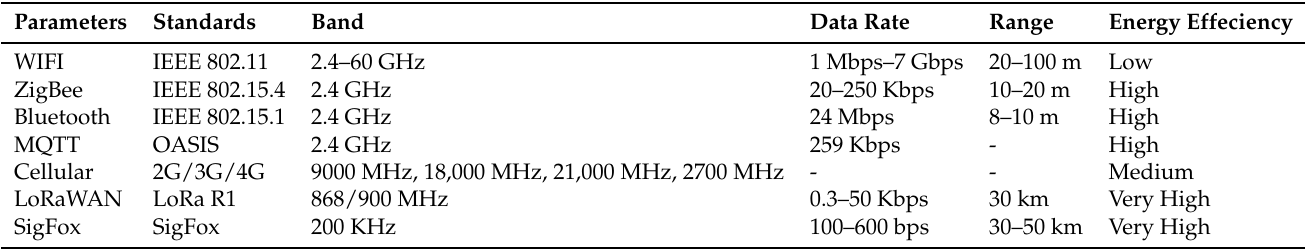
Table 2. Comparison between wireless transmission